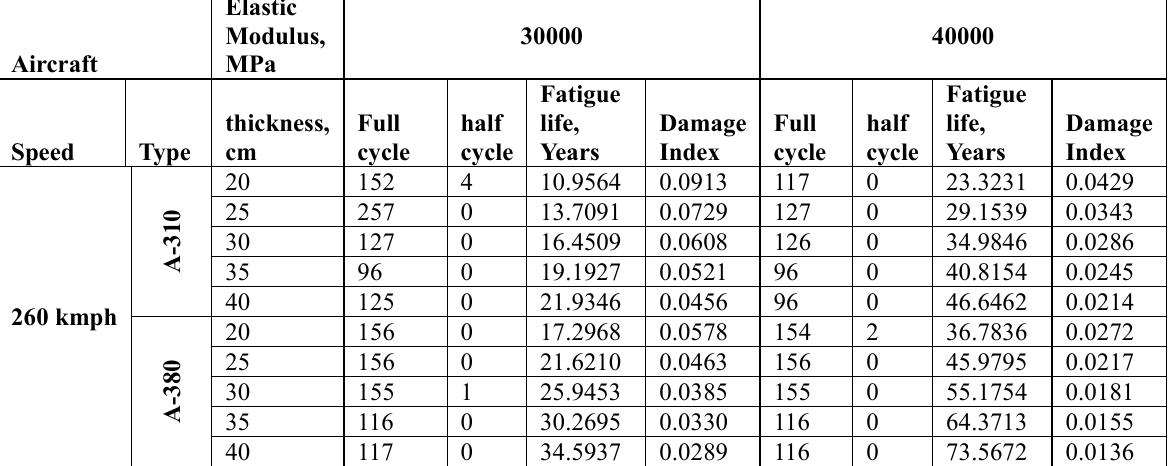
Fatigue life and Damage index for A-310 and A-380 having Take-Off Speed of 260 kmph.